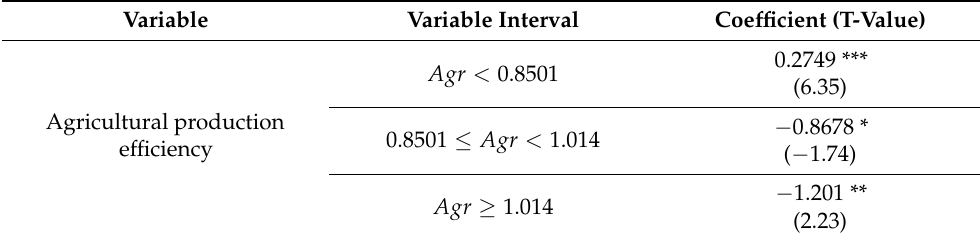
Table 7. Threshold regression